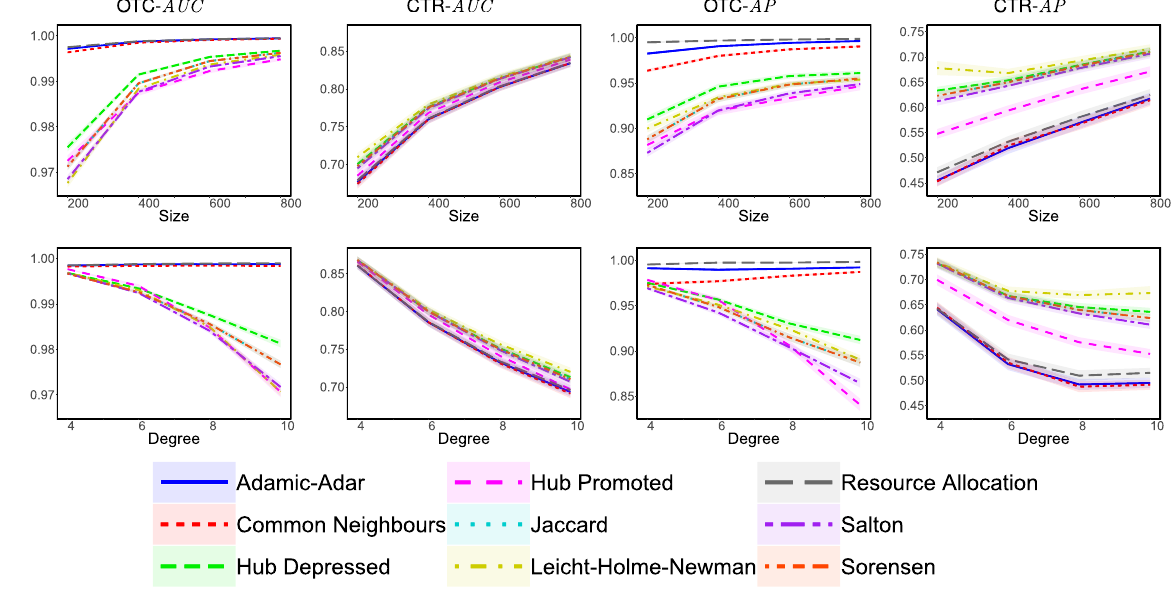
Figure 4. Evaluating the attack tolerance of different similarity indices against OTC and CTR in scale-free networks, while varying the number of nodes, n ∈ {200, 400, 600, 800}, and the average degree, d ∈ {4, 6, 8, 10}, where the attack tolerance is measured in terms of the relative change in AUC and AP . Specifically, for each combination of n and d we generate 50 scale-free networks; for each such network, G , we randomly select 10 evaders (each of which has at least 9 connections); for each such evader, v , we create 5 different sets H , each consisting of 3 random edges of v . Each instance of ( G , v , H ) constitutes a separate experiment. The results are reported as an average over different values of d for each n in the first row of subfigures, and as an average over different values of n for each d in the second row. Each point in each plot corresponds to an average over 10,000 experiments, with coloured areas representing the 95% confidence